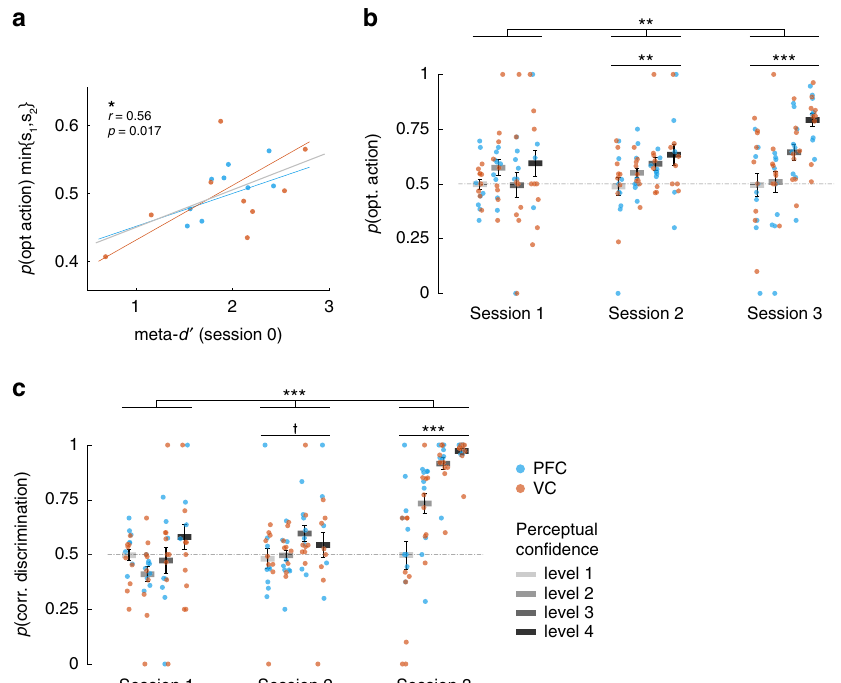
Fig. 4 Metacognition correlates with learning to use latent brain activity. a Across-subject correlation between the baseline (minimal) gambling performance attained in sessions 1 and 2, and individual metacognitive ability (how well one ’ s con fi dence tracks discrimination accuracy). Metacognitive ability was computed with independent behavioural data from the decoder construction session (session 0, see ‘ Methods'). Pearson correlation ( n = 18), two-sided p value. b Proportion of optimal actions plotted by con fi dence level. The performance was measured as the proportion of trials in which the subject chose the action more likely to be rewarded, given the latent state. Signi fi cance was assessed with linear mixed effects models (two-sided p values, uncorrected). c Discrimination accuracy, as leftward vs. rightward motion discrimination, plotted by con fi dence level. The correctness of the response was based on the output of the decoder. Signi fi cance was assessed with linear mixed effects models (two-sided p values, uncorrected). For all plots, coloured dots represent individual subjects, grey bars the mean, error bars the SEM. The experiment was conducted once ( n = 18 biologically independent samples). b **(interaction) P = 0.0017, **(session 2) P = 0.004, ***(session 3) P = 4.68 × 10 − 7 ; c ***(interaction) P = 4.68 × 10 − 6 , † (session 2) P = 0.078, *** (session 3) P = 7.03 × 10 − 14